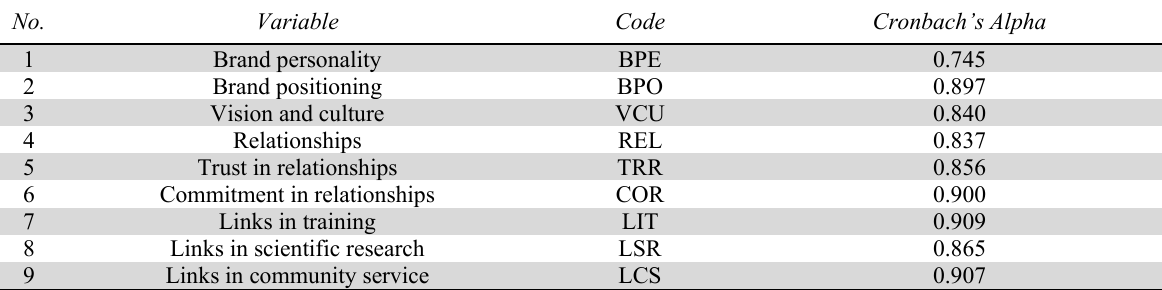
Rating the reliability of the scale through Cronbach's Alpha coefficient